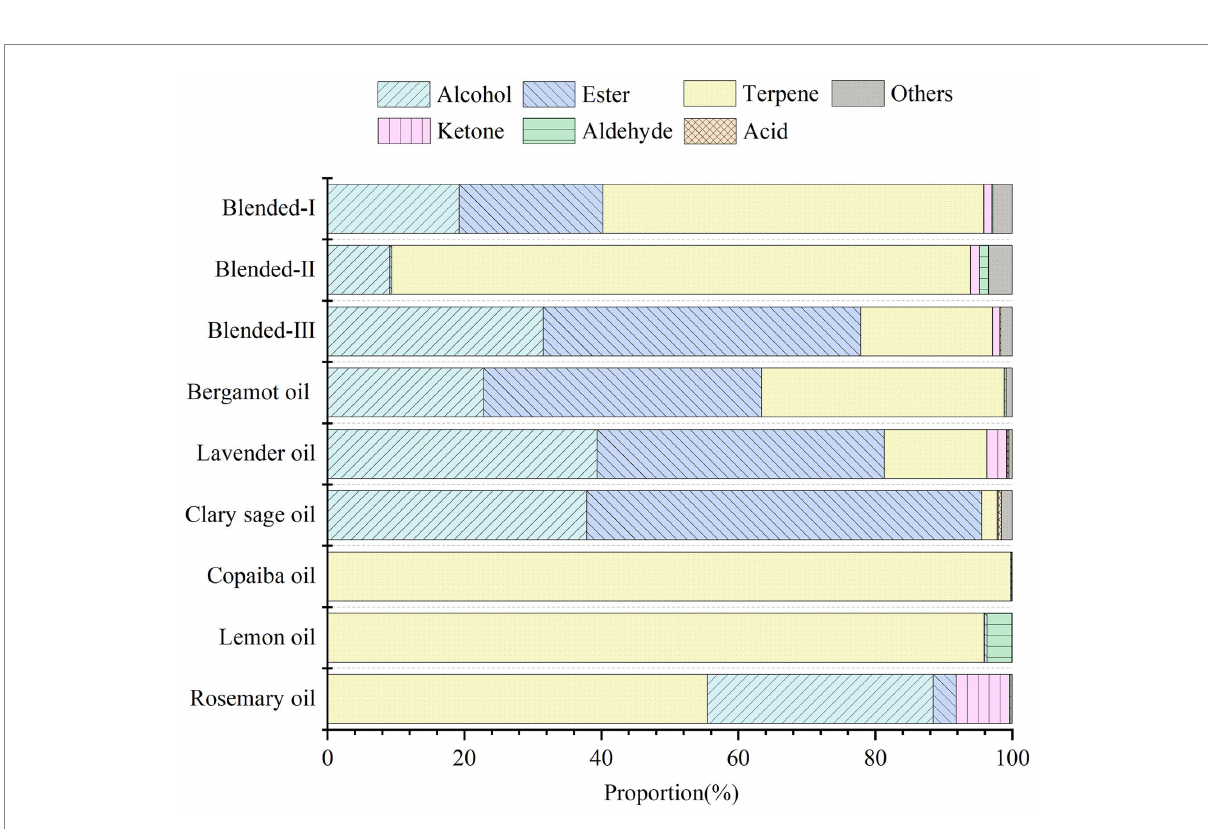
FIGURE 2 Distribution characteristics of compound types in different